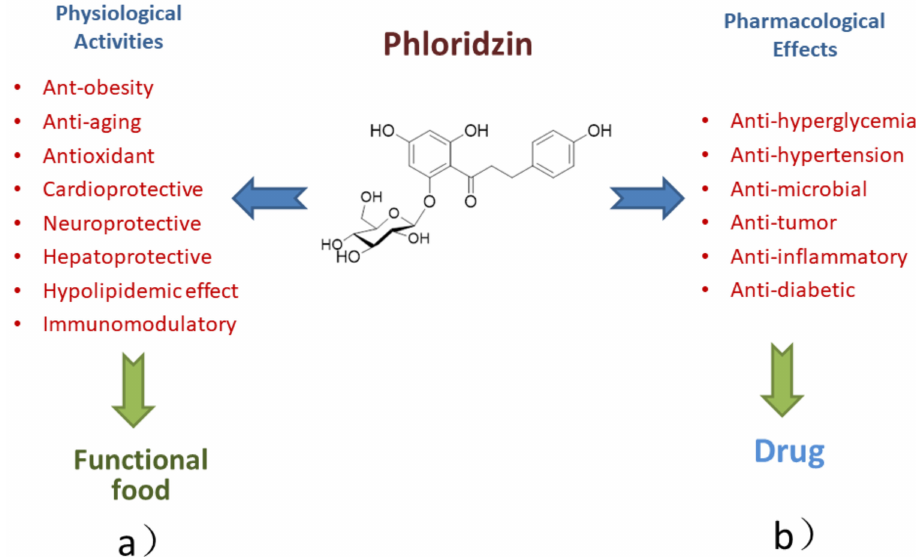
Figure 2. The potential applications and further use of phloridzin: ( a ) as an active compound in functional food and ( b ) as an active pharmaceutical ingredient in the pharmaceutical industry after